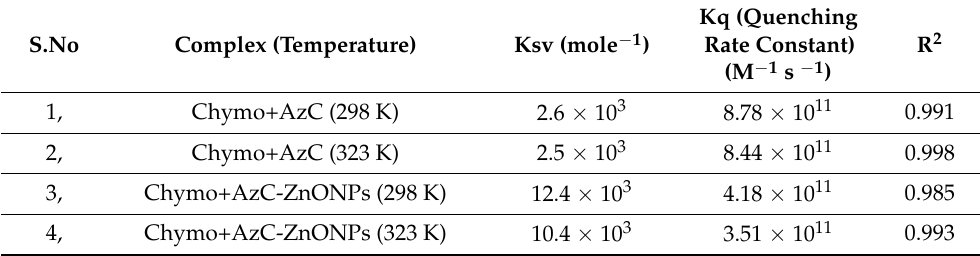
Table 2. The calculated values of Stern-Volmer constant (K SV ), quenching constant (Kq) of Chymo+AzC and AzC-ZnONPs at two different temperatures 293 K and 323 K.